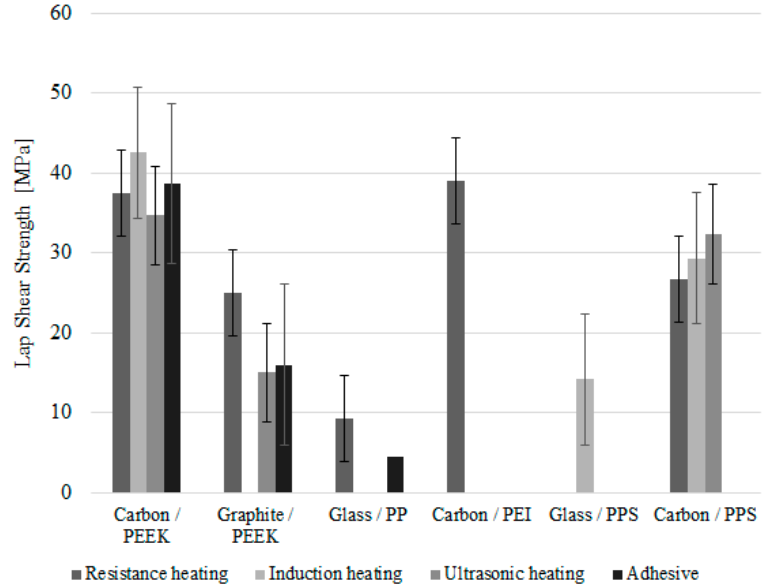
Figure 9. Experimental mean lap shear strength values of several of adhesive bonded and welded joints using thermoplastic based composites substrates.